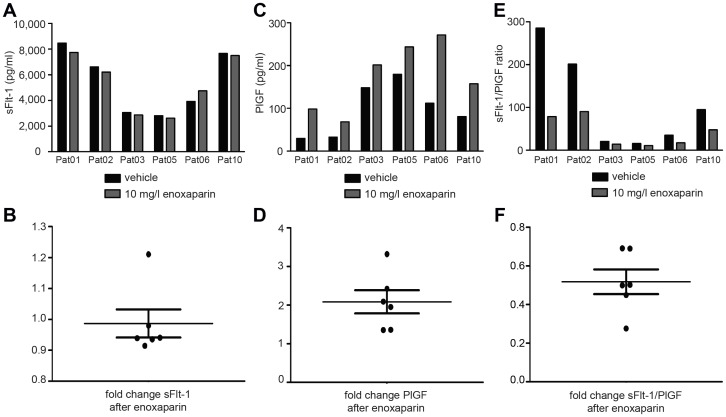
Addition of low molecular weight heparin in vitro affects PlGF measurements in the Elecsys Assay.Assessment of serum levels after the administration of enoxaparin or vehicle in vitro shows only marginal differences for sFlt-1 (A+B). In contrast PlGF levels appear falsely high after enoxaparin (C+D). Consequently the sFlt-1/PlGF ratio appears decreased (E+F).